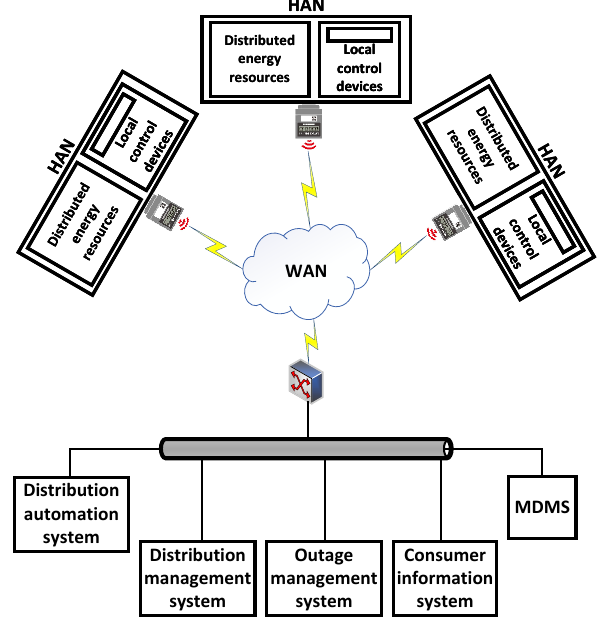
Figure 2. General structure of SKM.